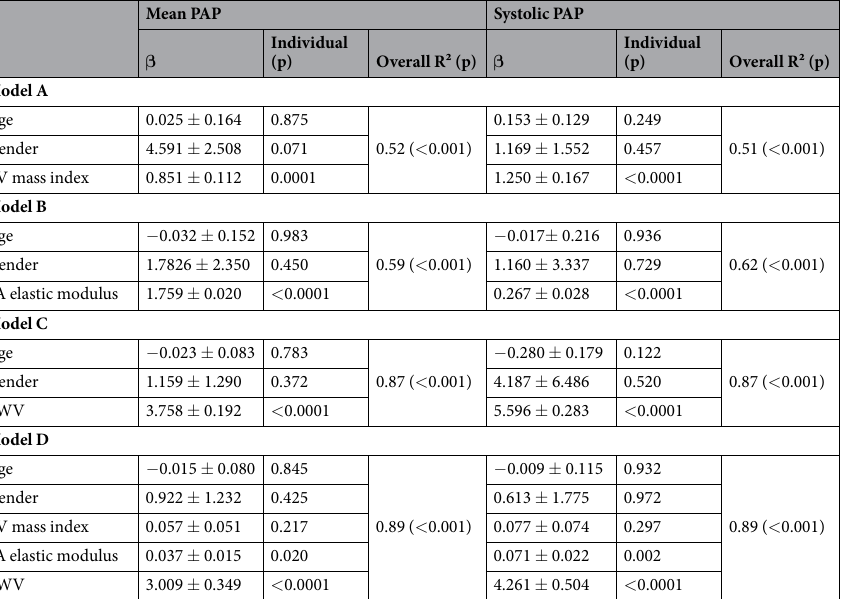
Table 4. Relationships between PAP and pulmonary artery stiffness indices. Abbreviations:: regression coefficient β is given for mean PAP and systolic PAP. Adjustment models: model A: age, gender; RVmass index; model B: age, gender; minimal PA area; model C: age, gender; PWV; model D: age, gender; RV mass index, PA elastic modulus and PWV. Abbreviations: RV, right ventricle; PA, pulmonary artery; PAP, pulmonary artery pressure; PWV, pulse wave